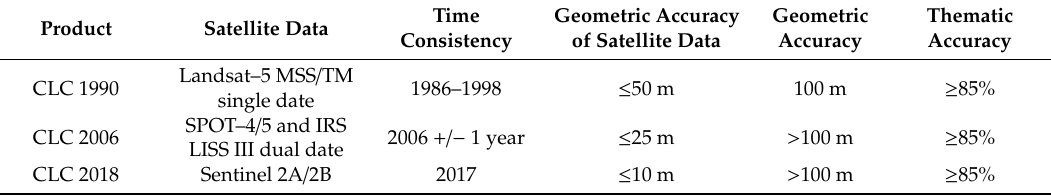
Table 1. Technical specifications for used CORINE Land Cover (CLC) dataset [64].